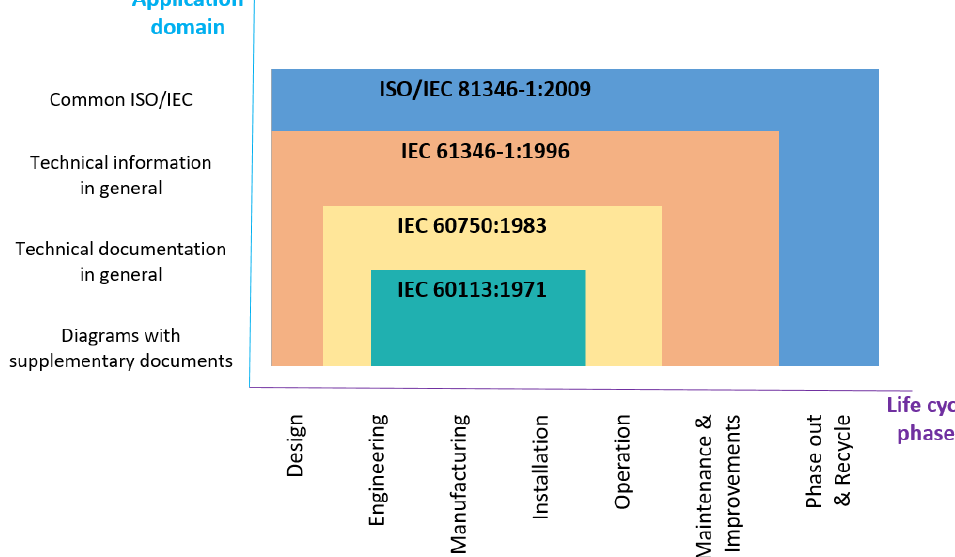
Figure 1. Scope of IEC standards supporting the product life cycle.